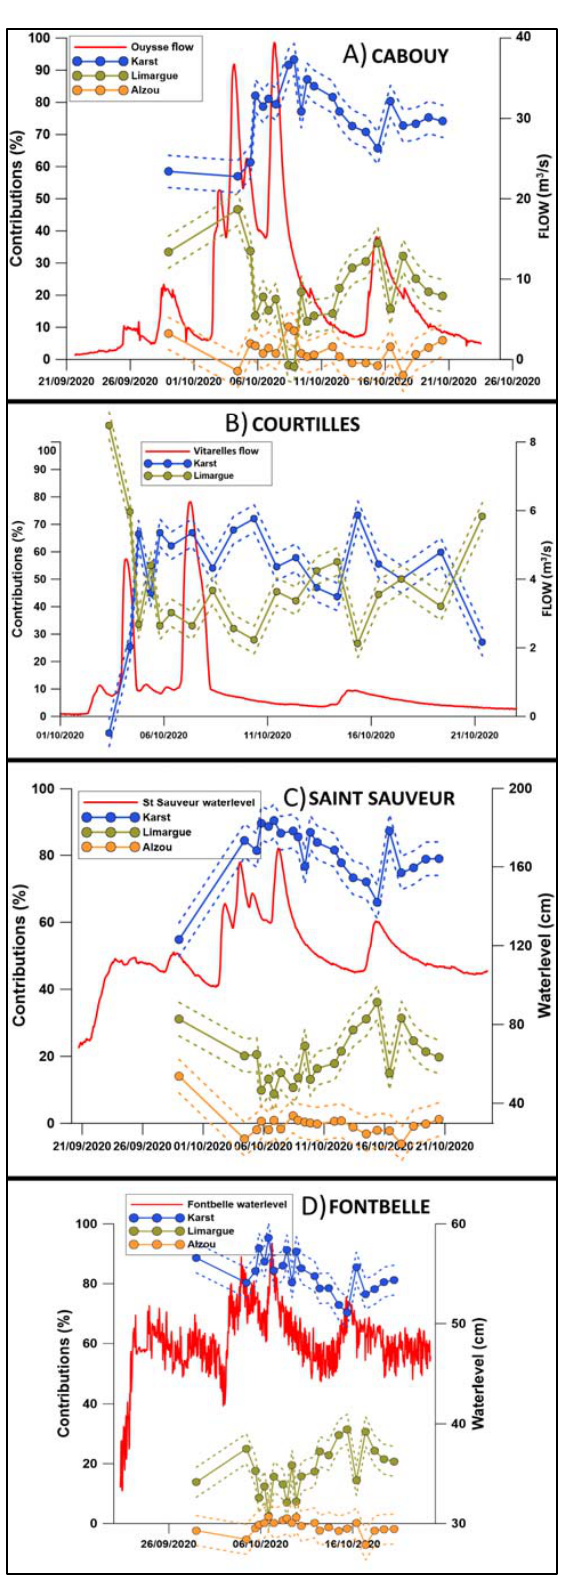
Figure 5. Evolution of the contributions results of the mobile source mixing model for Cabouy ( A ), Courtilles ( B ) Saint Sauveur ( C ), and Fontbelle ( D ) alongside water level. The dotted lines correspond to a positive and negative 5% error for each point.